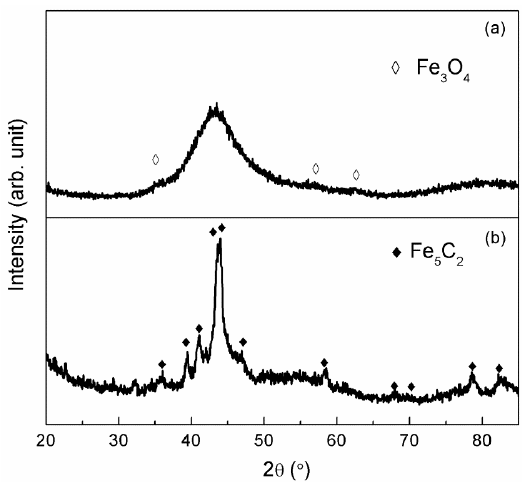
Figure 5. XRD patterns of the products heated at ( a ) 483 K and ( b ) 600 K in a vacuum.